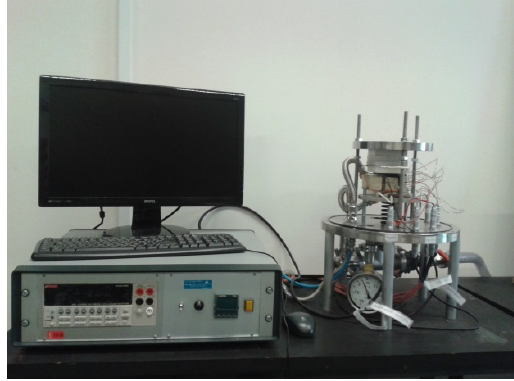
Figure 1. TEGeta experimental setup.